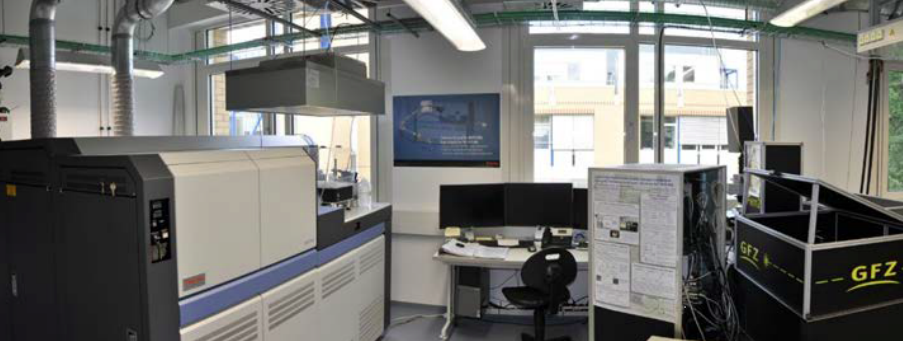
Figure 2: Mass spectrometry facilities at HELGES. Shown is the Inductively Coupled Plasma Multi- collector Mass Spectrometer (Thermo Neptune MC-ICP-MS) and the in-house built femtosecond laser ablation system (GFZ